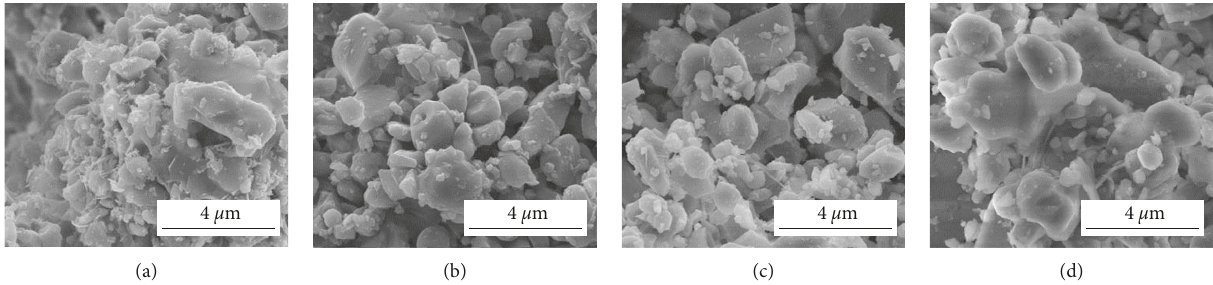
Figure 5: Microstructure of sample samples mixed and cured in the conventional static way containing (a) 40 vol.% and (b) 60 vol.% of water, (c) containing 80 vol.% of water after curing under rotation, (d) and containing 25 vol.% of water cast under isostatic